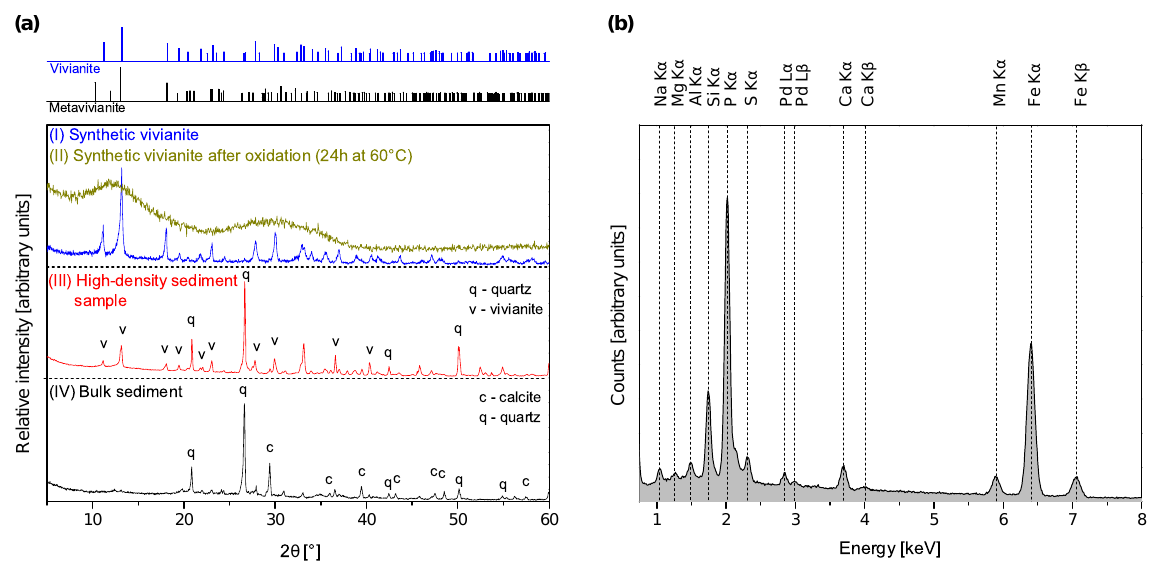
Figure 4. (a) XRD patterns of (I) synthetic vivianite, (II) synthetic vivianite after oxidation at 60 ◦ C for 24h, (III) high-density sample and (IV) bulk sediment. Characteristic reflexes of vivianite could only be observed after heavy-liquid separation in the high-density sample (III). The line patterns of vivianite (blue, file number 96-901-2899) and metavivianite (black, file number 96-100-1784) use data from the Crystallography Open Database (COD) REV 64680 (2012 edition). (b) SEM-EDX elemental spectrum obtained from a dark blue sediment concretion from Lake Groß-Glienicke. The corresponding atomic Fe:P ratio is 1.49. Elemental peaks of carbon and oxygen are omitted.